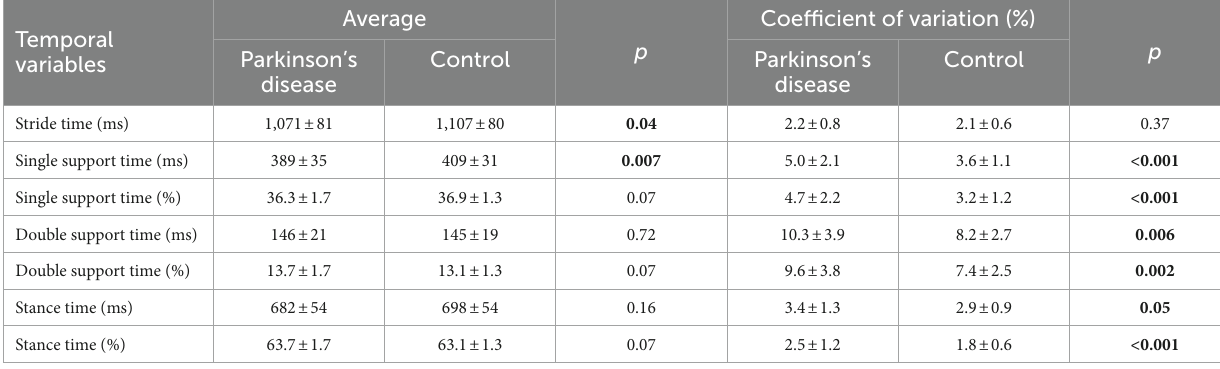
TABLE 2 Temporal variables for Parkinson’s disease and control